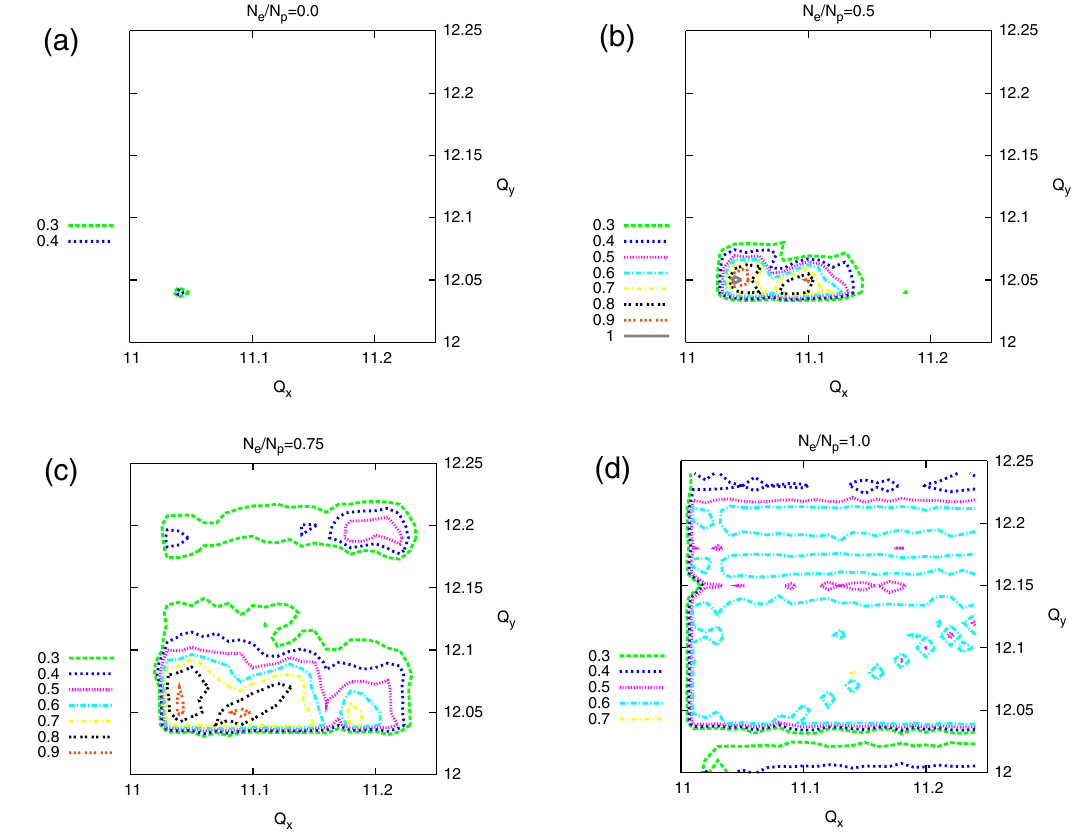
FIG. 3. (Color) Geometric luminosity factor F as a function of tunes with different degrees of head-on beam-beam compensation, geom with beam and machine parameters as shown in Table